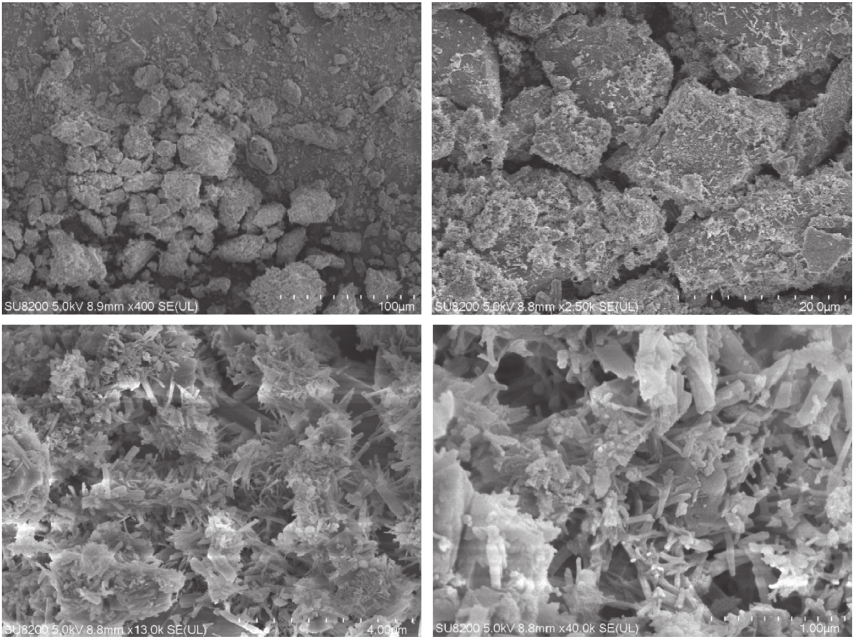
Figure 8: Microstructure of Group 6.